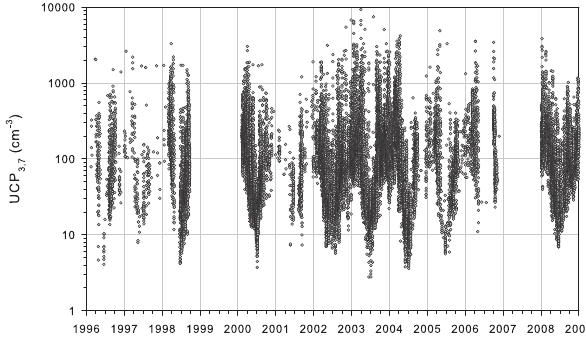
Fig. 5. Measured concentrations of ultrafine particles, UCP 3 , 7 ( D p between 3nm and 7nm) based on hourly means. Note that the larger data gaps from late 1998 until early 2000 and fall 2006 through 2007 were caused by malfunction of the UCP 3025A.